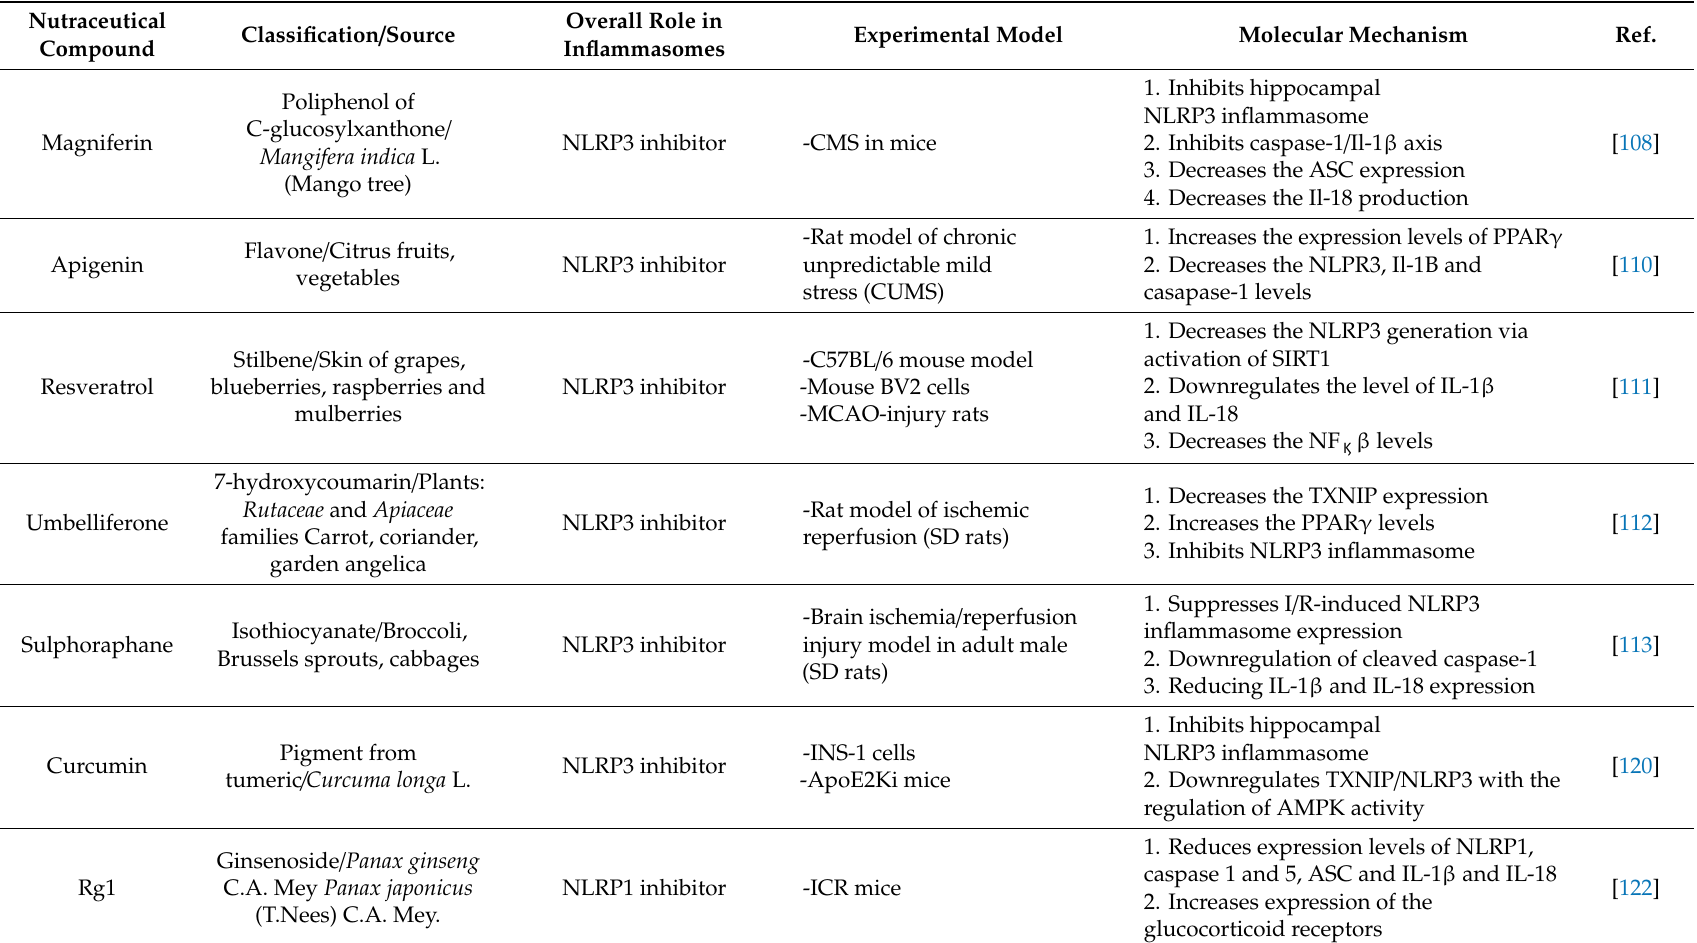
Table 3. List of Nutraceutical Compounds targeting Inflammasomes in Neurodegenerative